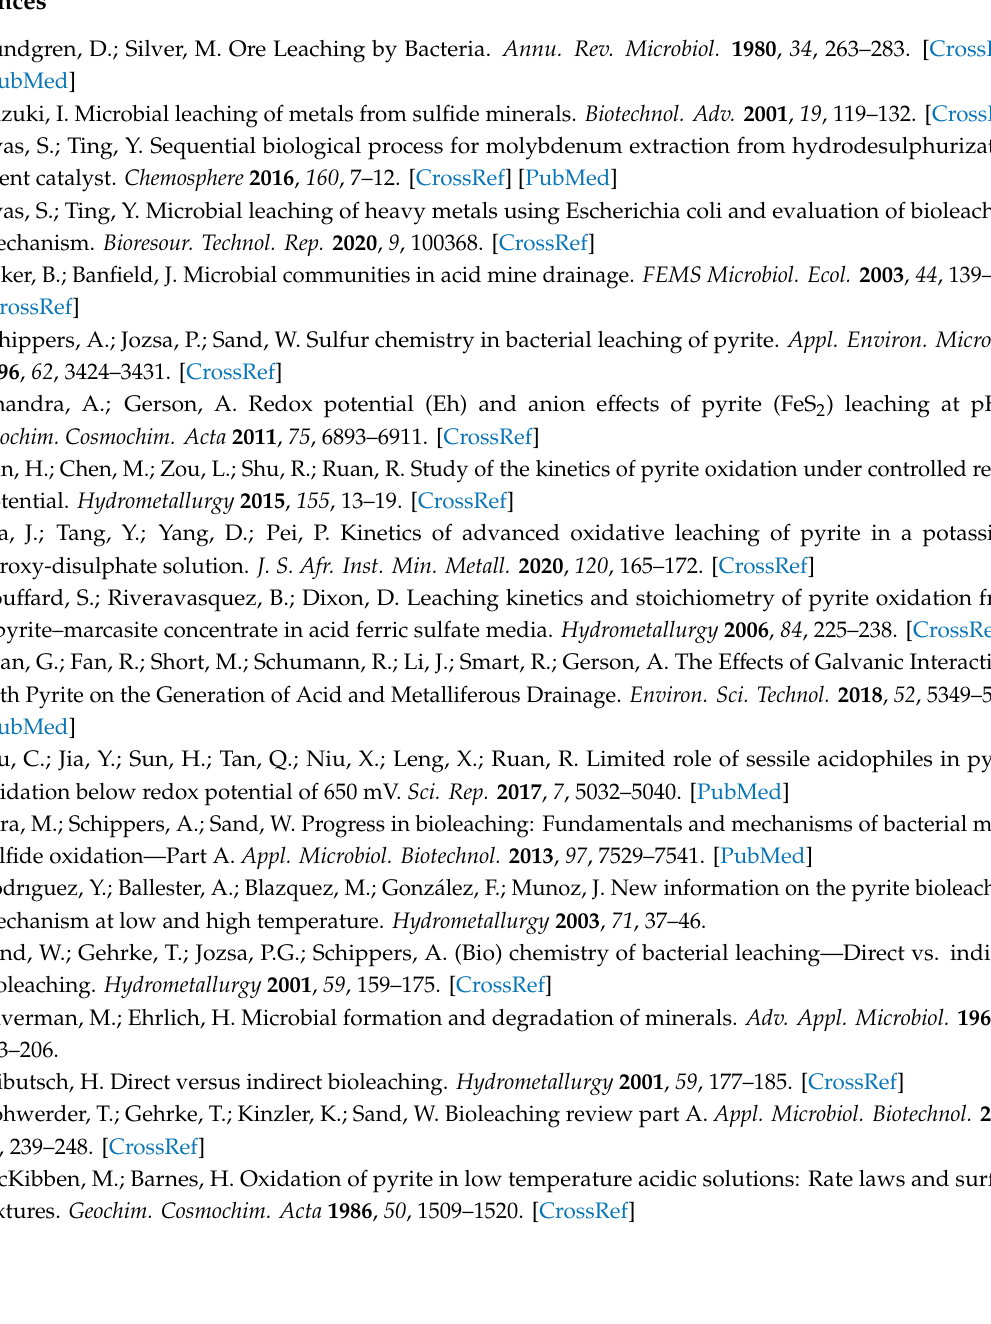
Table S1: The percentage of S 2p species on the surfaces of residue under di ff erent conditions, Table S2: The percentage of Fe 2p3 / 2 species on the surfaces of residue under di ff erent